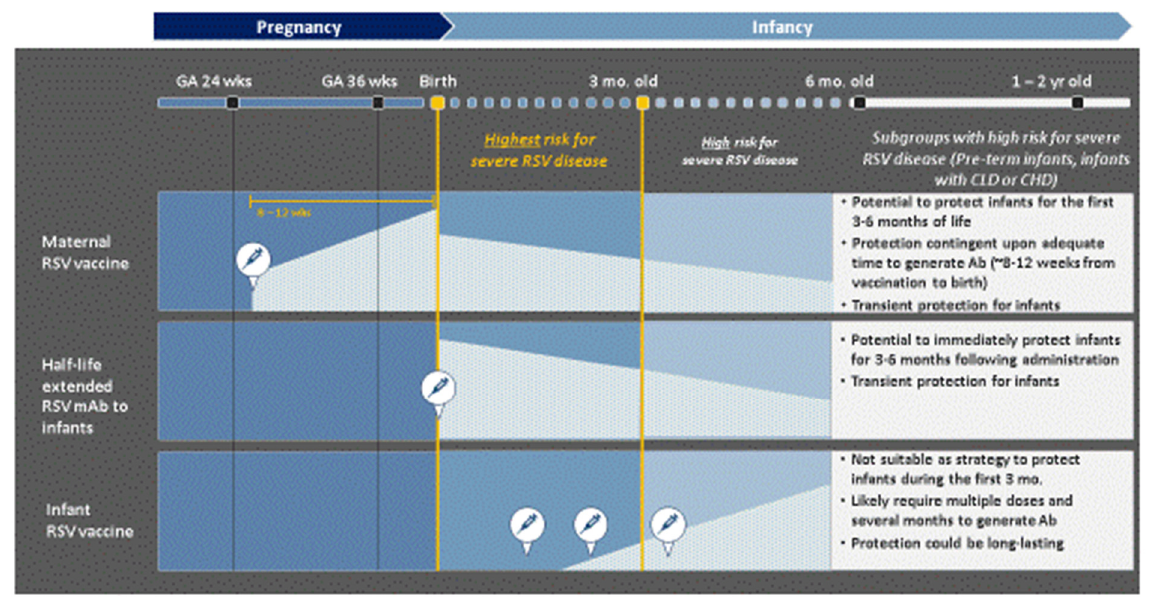
Figure 2. RSV-preventing strategies for infants.